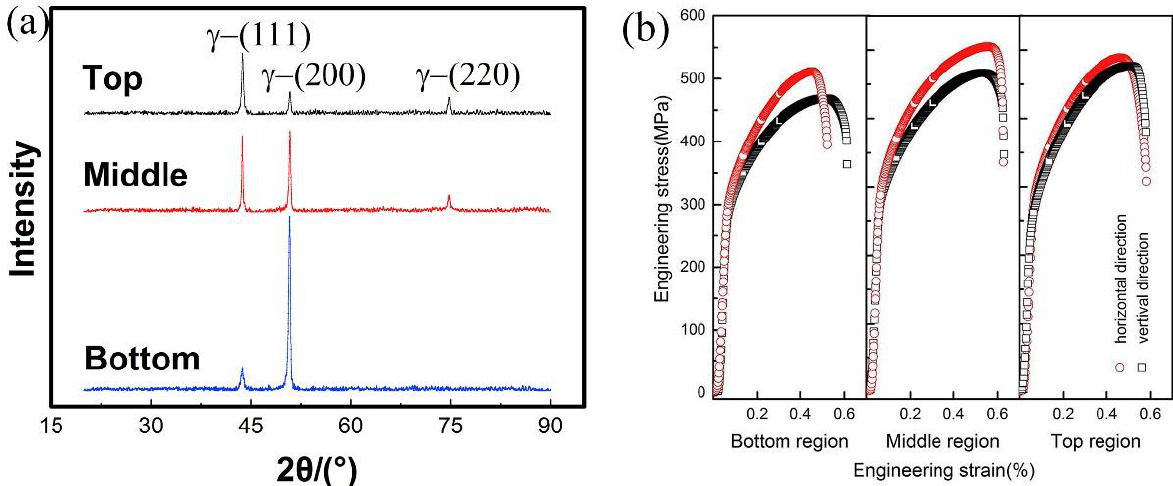
Figure 6. XRD patterns (Cu-Kα) of samples at ( a ) different height and curves of engineering stress vs. ( b ) engineering strain for wire-feed laminar plasma AM AISI308L steel. Reprinted with permission from [46], Copyright 2020 Elsevier.